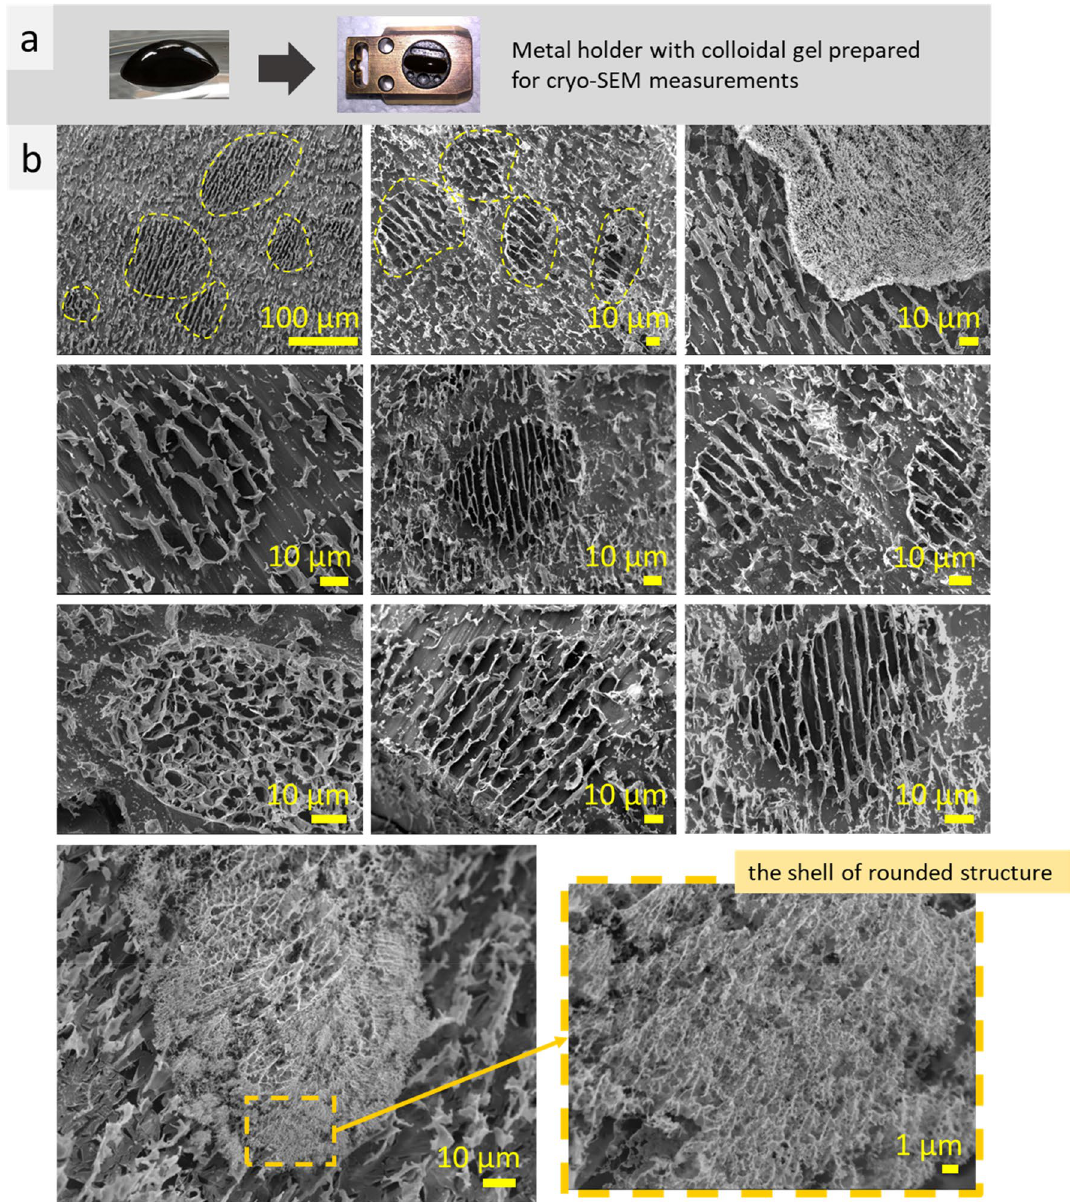
Figure 3. Photos of a drop of MAg NPs hydrocolloid with rhodamine B and specimen shuttle with 10 mm aluminum holder with the sample prepared for cryo-SEM measurements ( a ), cryo-SEM images of MAg NPs hydrocolloid with rhodamine B: rounded structures are circled by dotted lines ( b